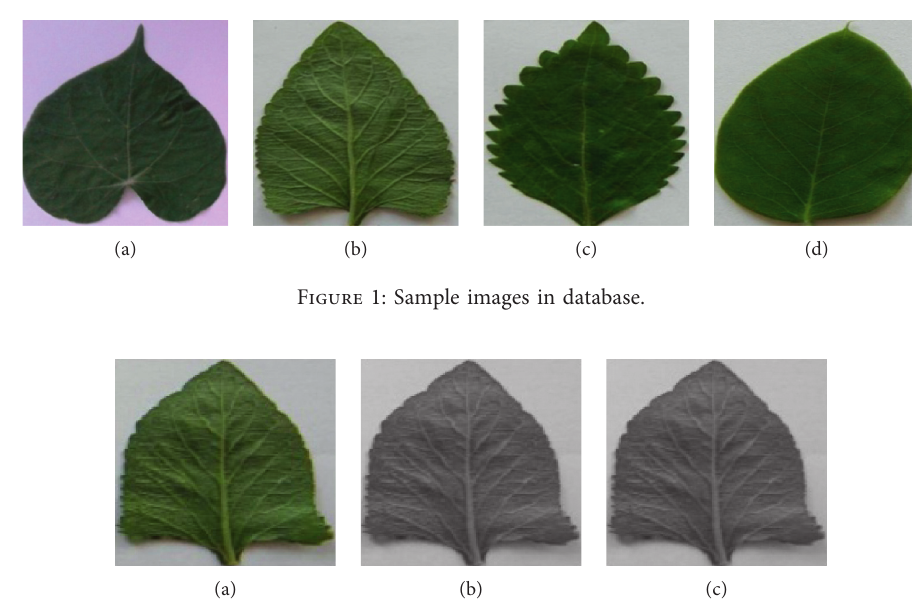
Figure 2: Preprocessing of grass leaf image. (a) Original image; (b) grayscale image; (c) denoised image.